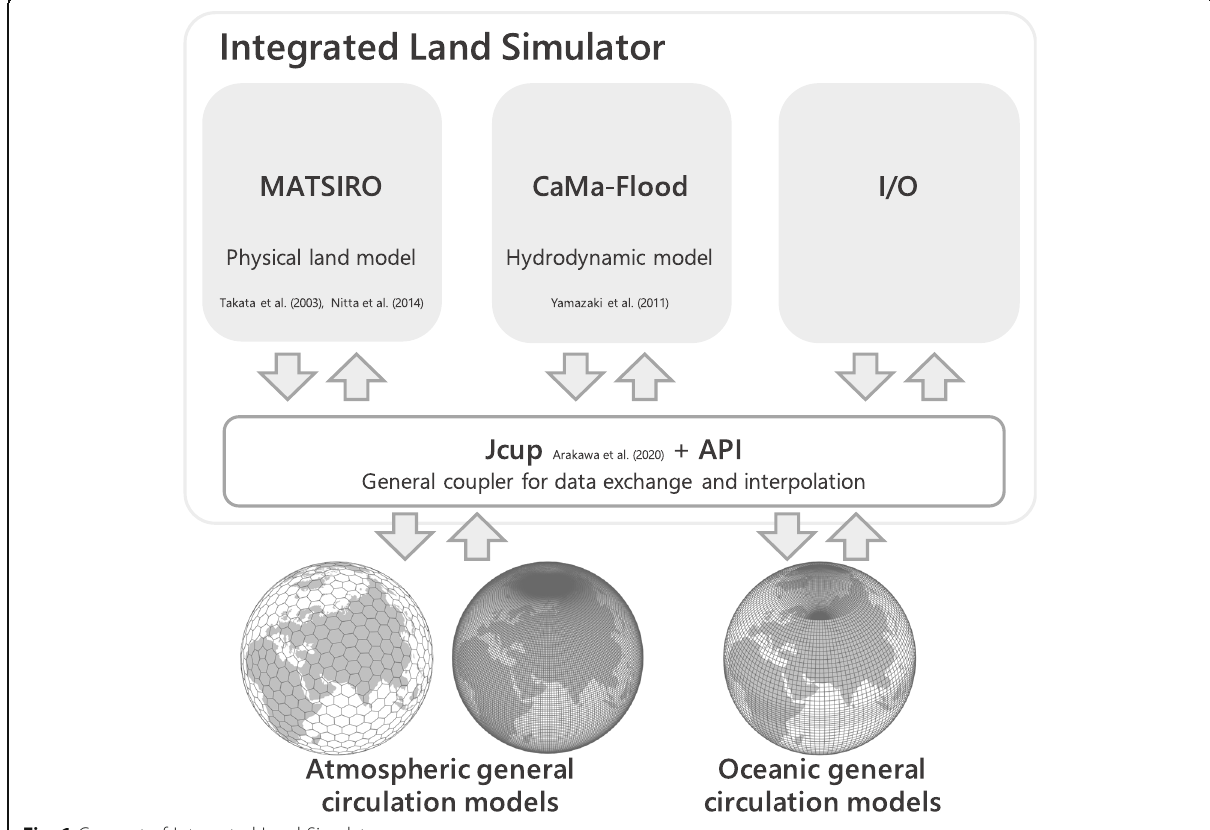
Fig. 1 Concept of Integrated Land